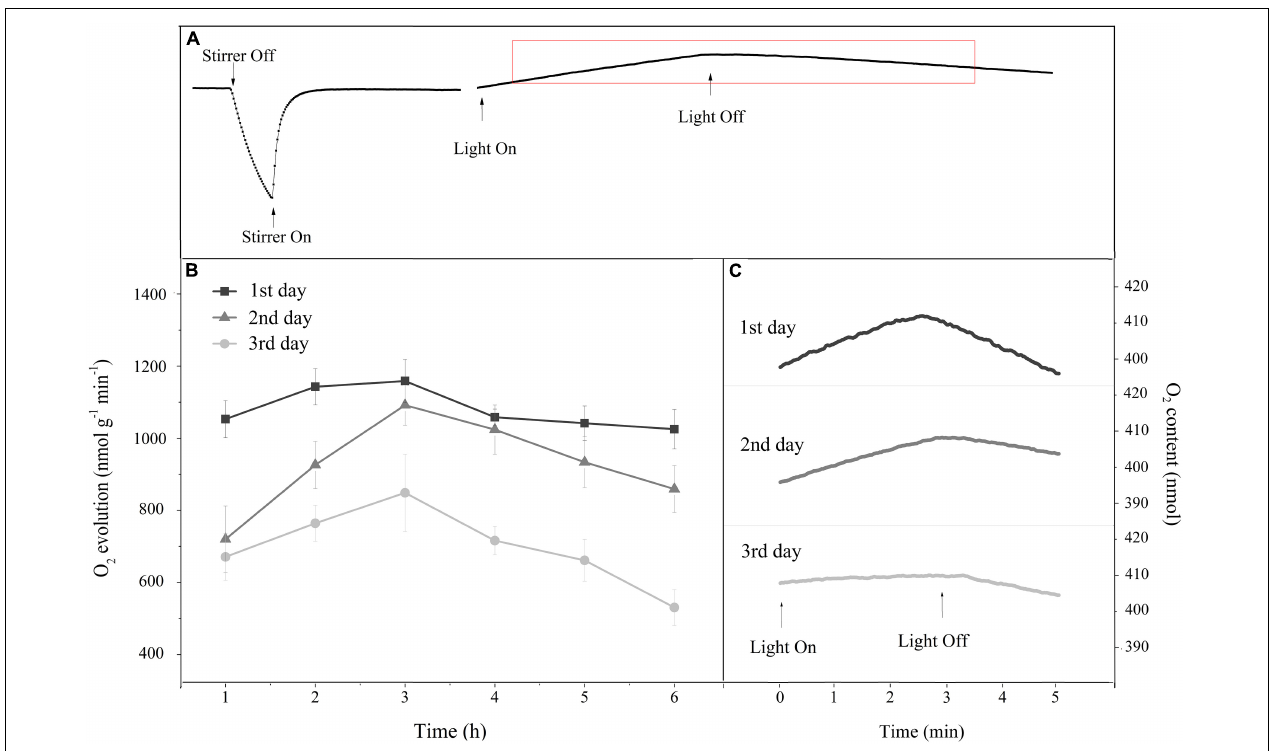
FIGURE 5 | (A) A typical oxygen content change curve in the reaction chamber of the Liquid-Phase Oxygen Electrode System for monitoring the O 2 evolution rate. (B) Time course of the O 2 evolution rate in response to 6 h of HL (400 µ mol photons/m 2 s) exposure per day for 3 continuous days. Square, triangle, and circle represent the continuous exposure for 1st, 2nd, and 3rd day, respectively. The means ± SD were calculated from three independent samples. (C) Changes in the oxygen content curve during the O 2 evolution rate monitoring after 6 h of continuous HL exposure per day. The rising slope of the curve under light represents the net photosynthetic rate, and the falling slope of the curve in darkness represents the respiration rate. Each curve is based on the average of three